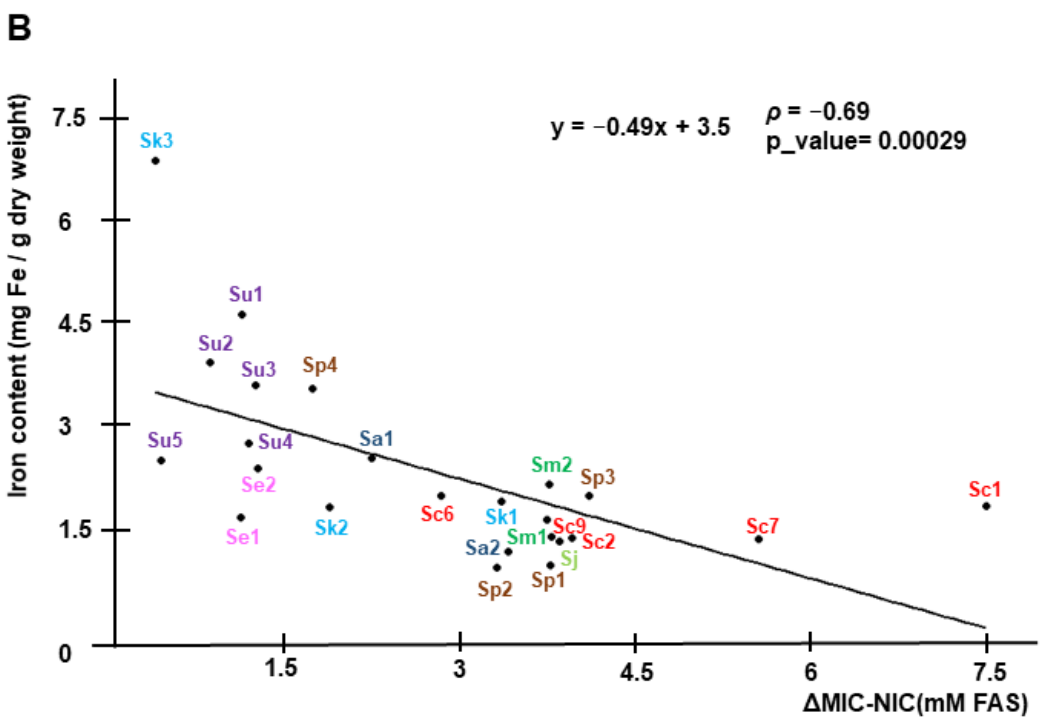
Figure 3. Iron accumulation under high-iron conditions and correlation with iron sensitivity. ( A ). Overnight precultures of yeast strains were reinoculated at an OD600 of 0.2 in liquid SC medium with 4 mM FAS and grown for 24 h. Then, cells were collected and endogenous iron (mg Fe/g dry weight) was determined as indicated in Materials and Methods. Data and error bars represent the average and standard deviation of at least three independent biological replicates. Strains are ordered according to the MIC values depicted in Figure 2. ( B ). Scatter plot analysis of ∆ MIC-NIC (x axis) and iron content (y axis) variables. Spearman’s correlation equation is shown, together with Spearman’s rank coefficient (ρ) and a p _value. Colors and strain abbreviations follow the same code as in Figure 1.